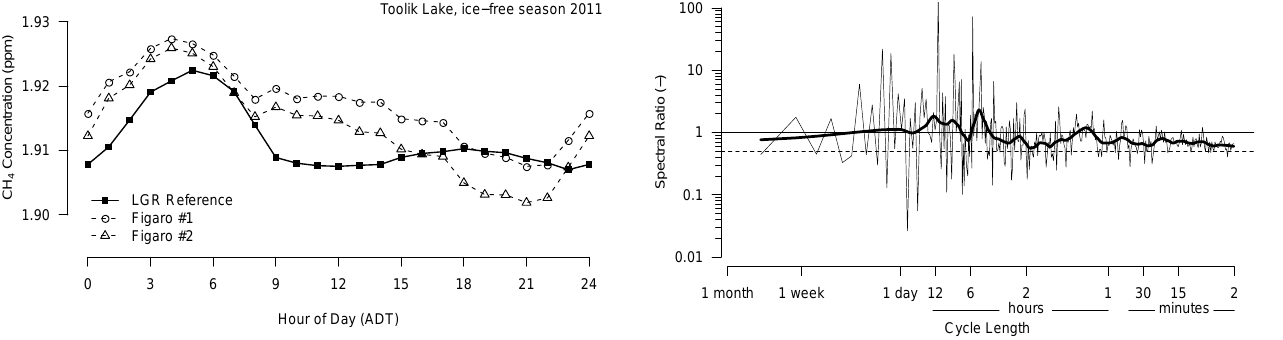
Fig. 5. Mean diurnal cycle of CH 4 concentrations over Toolik Lake during the ice-free season 2011. One-minute averages were aggre- gated by hour of day (Alaska Daylight Time). The standard error of the mean is of the same size as the symbol and hence is not added to the graph. The two low-cost sensors compare well with the Los Gatos Research reference analyzer during the first part of the day and correctly reflect the daily peak concentrations in the near-surface atmosphere.